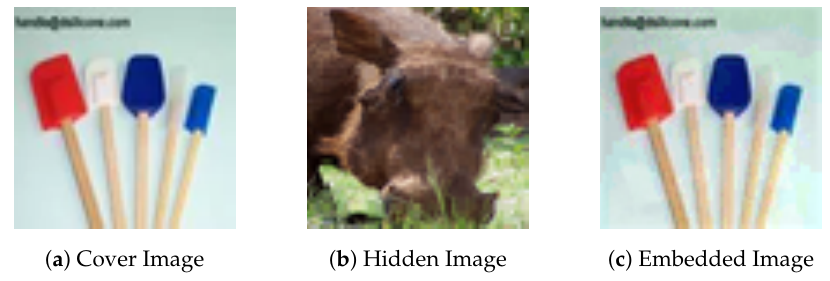
Figure 1. Vague Outline Visible in 4-bit LSB Steganography Embedded-Cover-Diversity = 50%, Hidden-Decoded-Diversity = 50%, Payload Capacity = 12